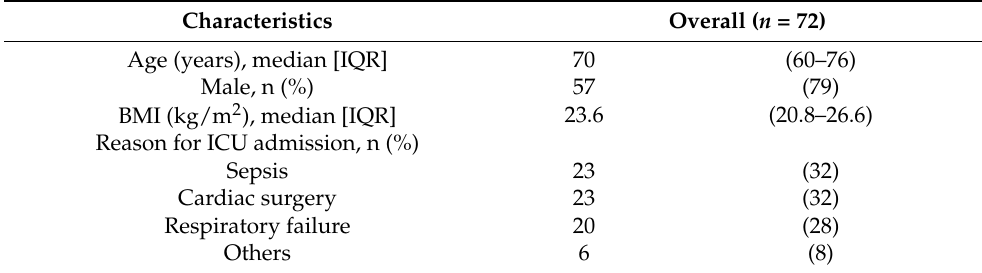
Table 1. Patient